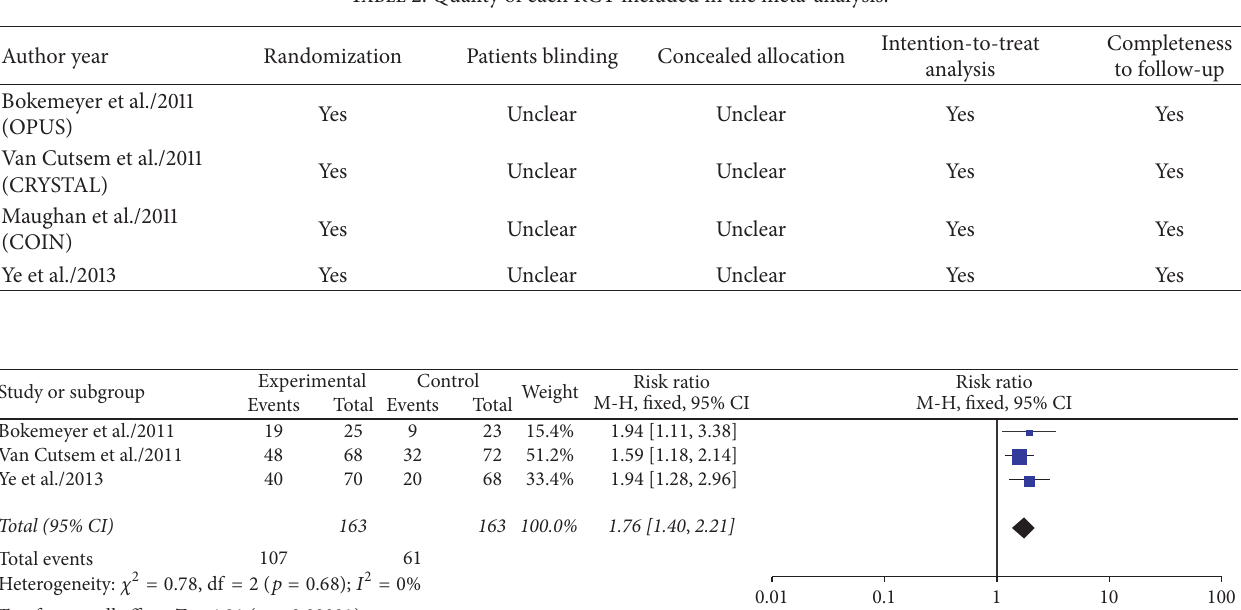
Table 2: Quality of each RCT included in the meta-analysis.